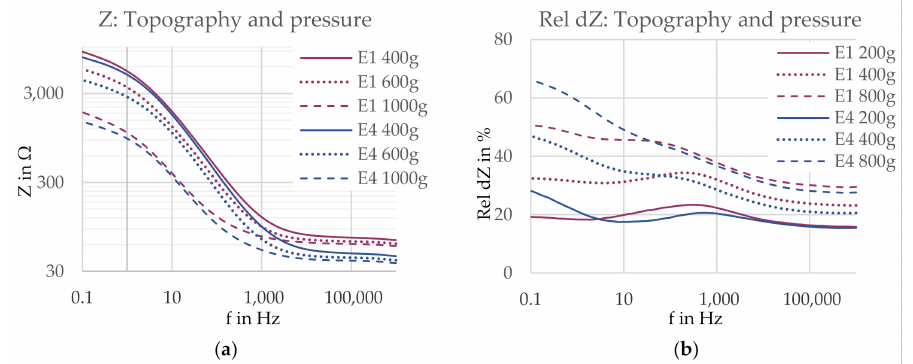
Figure 18. ( a ) Contact impedance Z and ( b ) impedance change rel dZ for electrodes with a smooth surface (E1, 17.4 cm 2 , pink) and an uneven surface (E4, 20.9 cm 2 , blue). Electrode versions are marked with different colors and pressure levels are marked with different line